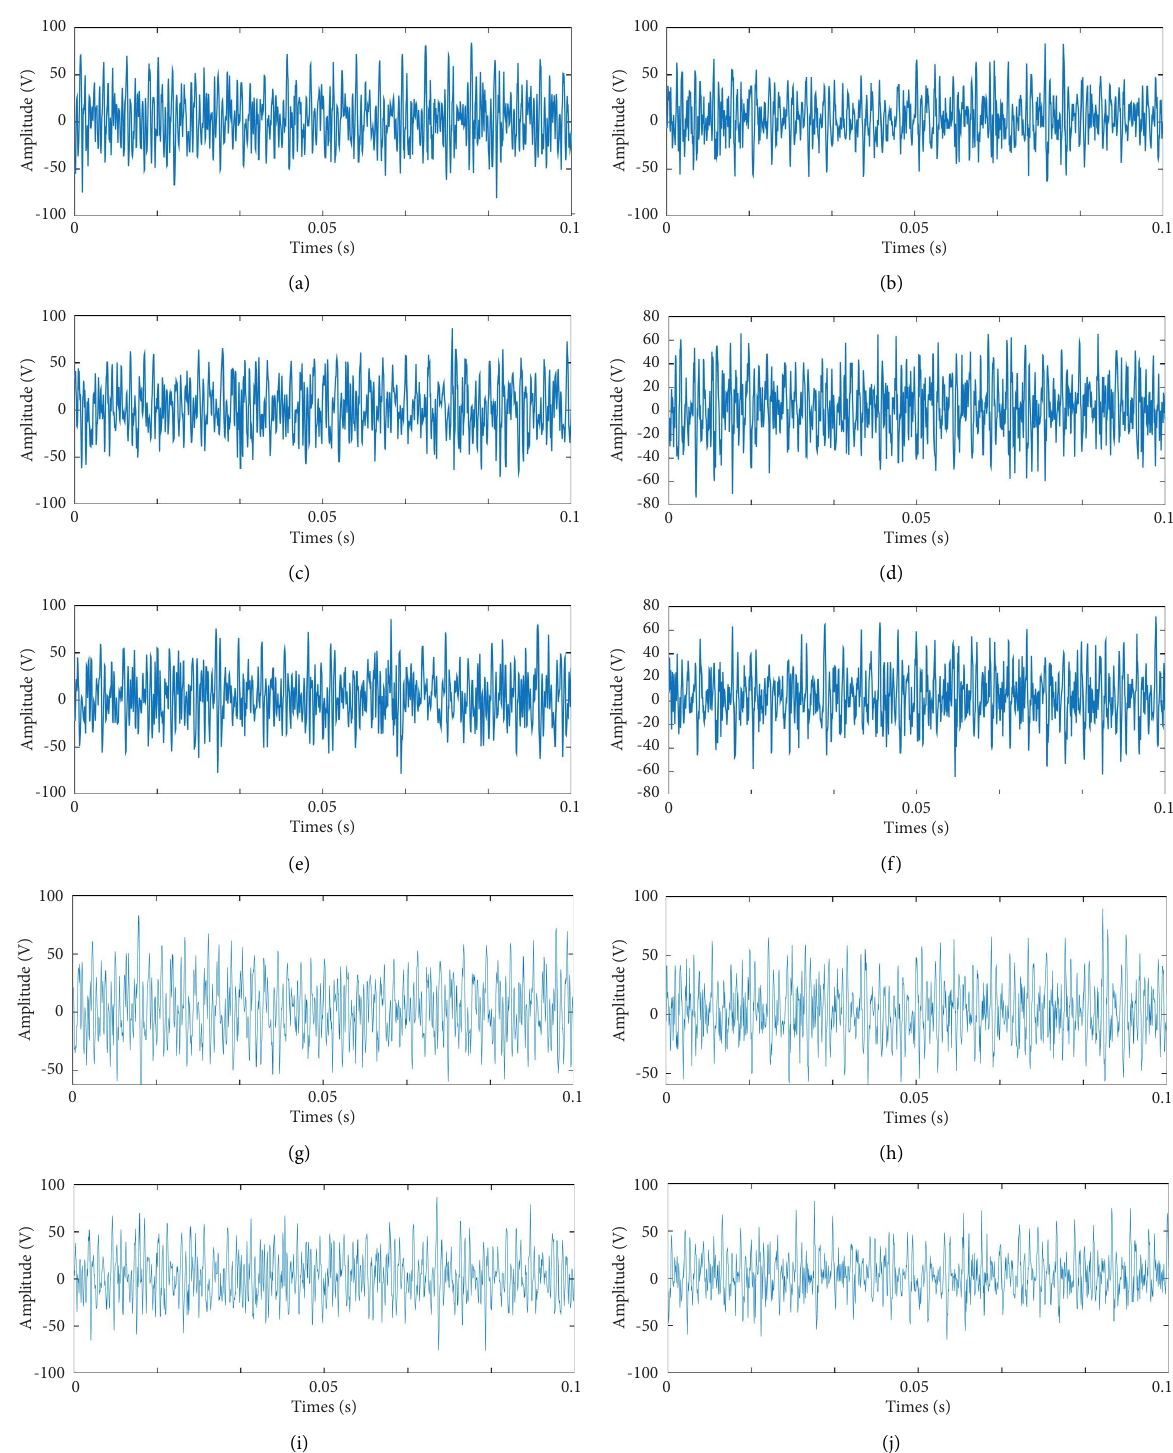
Figure 12: Time-domain diagram of the vibration signal: (a) condition1-nomal, (b) condition2-nomal, (c) condition1-Z15, (d) condition2- Z15, (e) condition1-Z18, (f) condition2-Z18, (g) condition1-Z30, (h) condition2-Z30, (i) condition1-Z31, and (j)